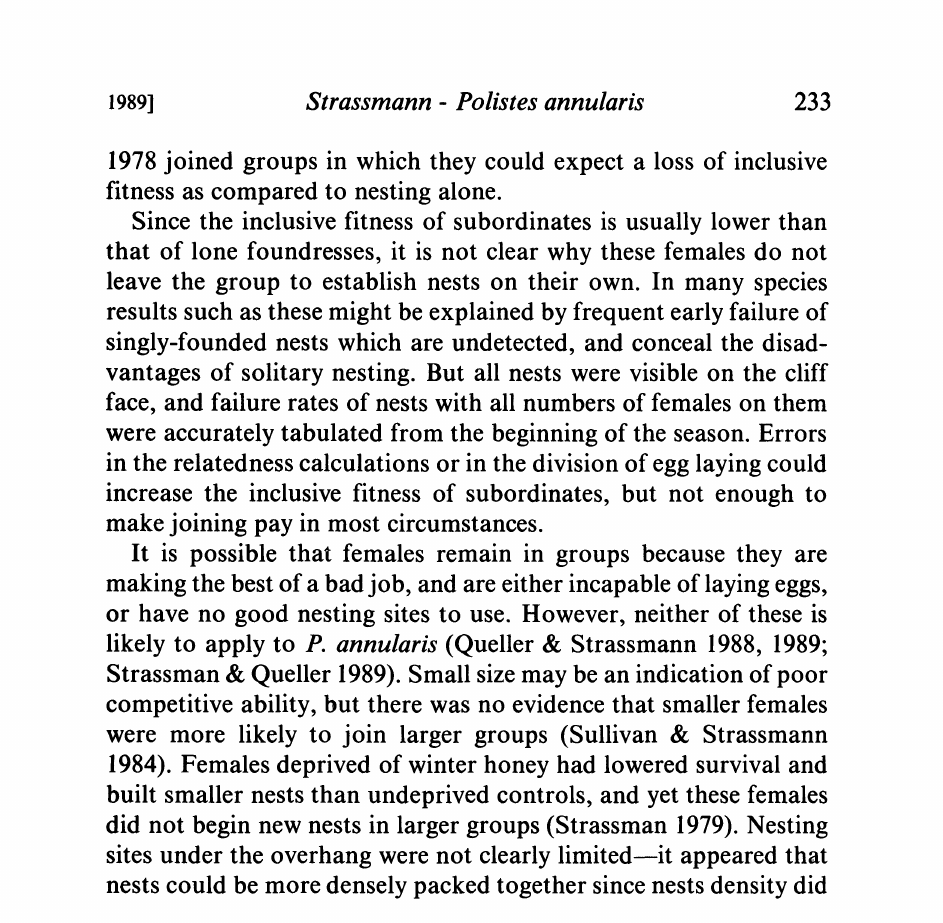
Table 4. Regression equations of pupae at worker emergence and gynes at end of season on foundress number. #of